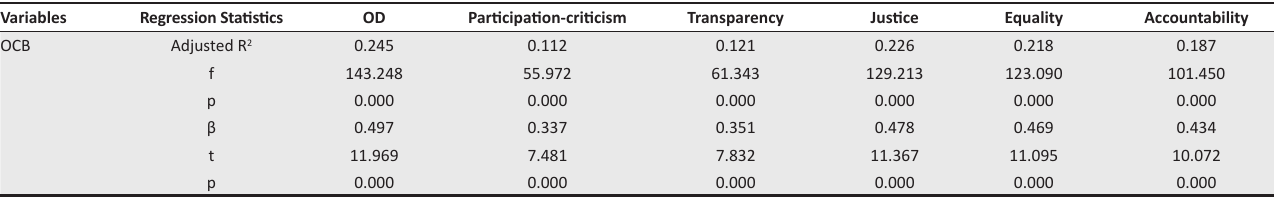
TABLE 5: Regression analyses: Influence of organisational democracy on organisational citizenship behaviour. Variables Regression Statistics